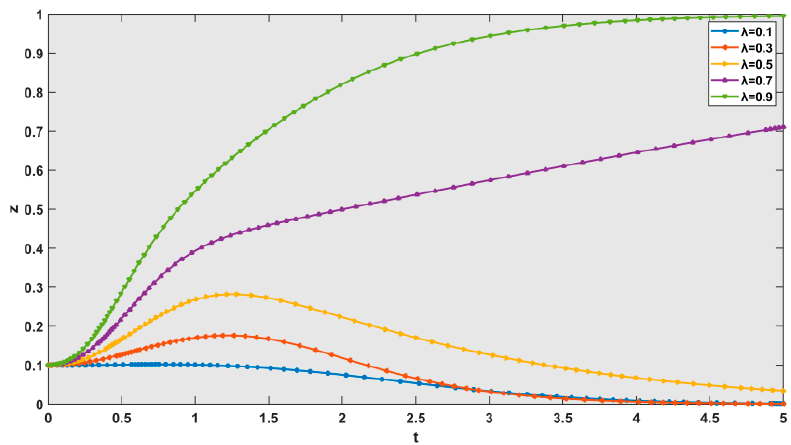
Figure 7. The influence of the change of λ on the potential demand-oriented enterprises’ evolution trajectory.